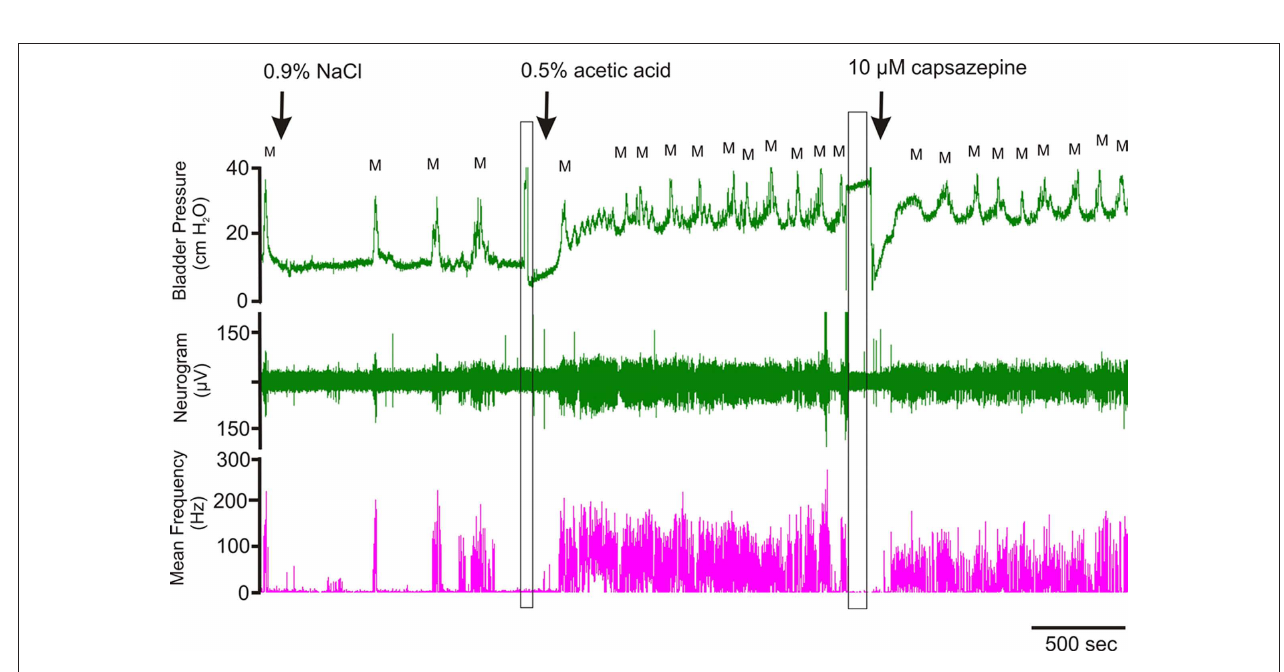
pressures. This change in bladder function was associated with increased nerve activity. Addition of capsazepine to the acetic acid solution reduced the number of non-voiding contractions and nerve activity. The rectangles mark the points in the experiment where the infusate was changed ( M , micturition